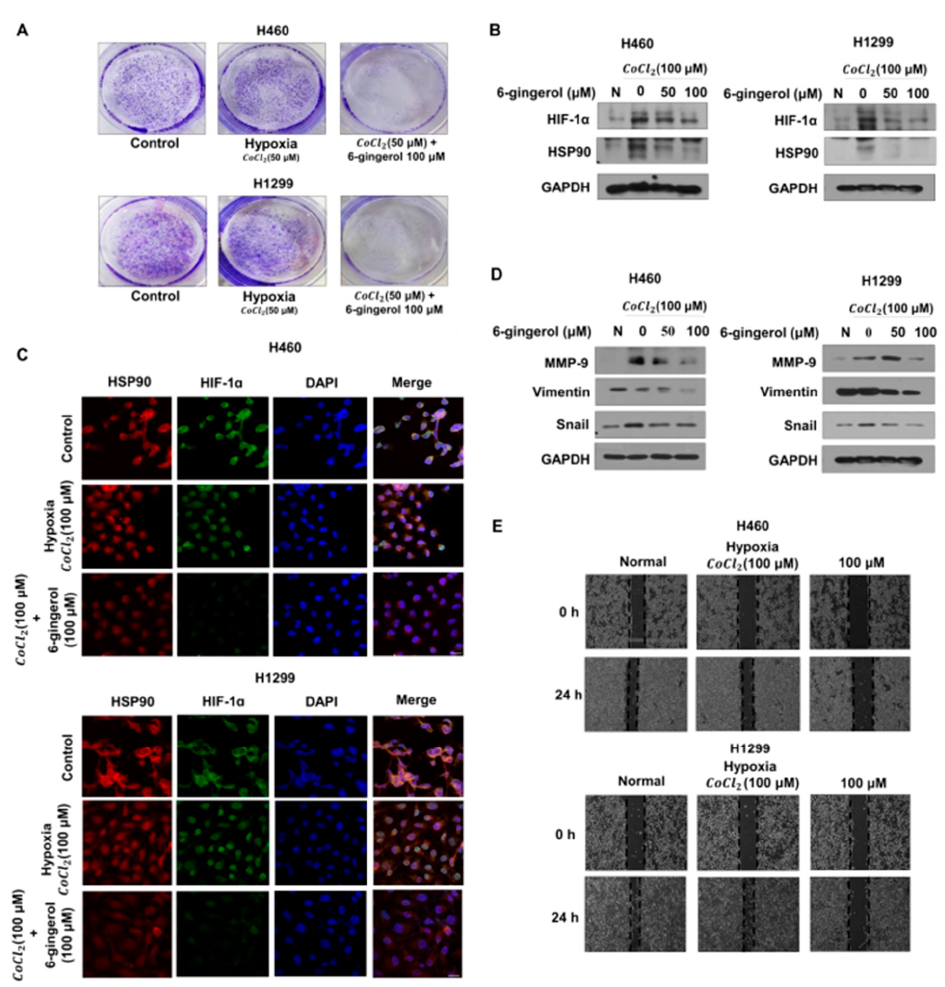
Figure 6. 6-Gingerol treatment inhibited metastasis by disrupting HIF-1 α stabilization by decreasing the protein level of HSP90 under hypoxia. Pretreatment with 𝐶𝑜𝐶𝑙 (cid:2870) for 4 h was followed by 6-gingerol treatment. ( A ) H460, A549 and H1299 cells were exposed to 6-gingerol for 7 days. The effect on cell proliferation under hypoxia was assessed by using a colony formation assay. ( B ) Whole-cell lysates were analyzed by Western blotting with anti-HIF-1 α and anti-GAPDH antibodies. ( C ) Confocal images demonstrating the subcellular localization of HIF-1 α (green) and the HSP90 (red) complex after treat- ment with 6-gingerol under hypoxia are shown. Nuclei were stained with DAPI (blue). ( D ) Whole-cell lysates were ana- lyzed by Western blotting with anti-HIF-1 α and anti-GAPDH antibodies. ( E ) The migration of 6-gingerol-treated cells under hypoxia was assessed by using a wound healing assay. The data are presented as the mean ± SEM. compared to untreated cells.